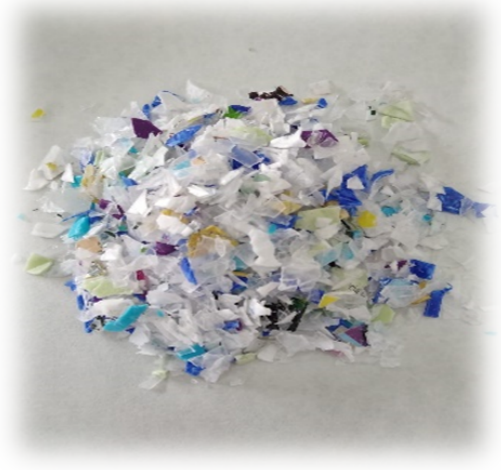
Figure 2. Recycled polypropylene.